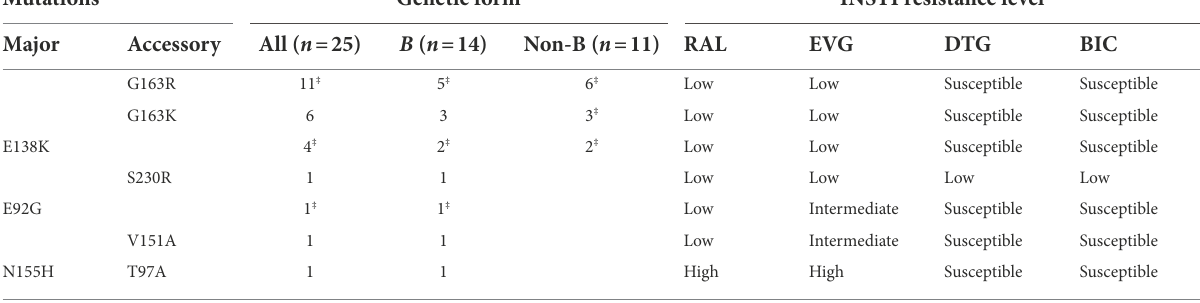
TABLE 3 Predicted resistance level and INSTI mutations identified in INSTI-naïve patients. Mutations Genetic